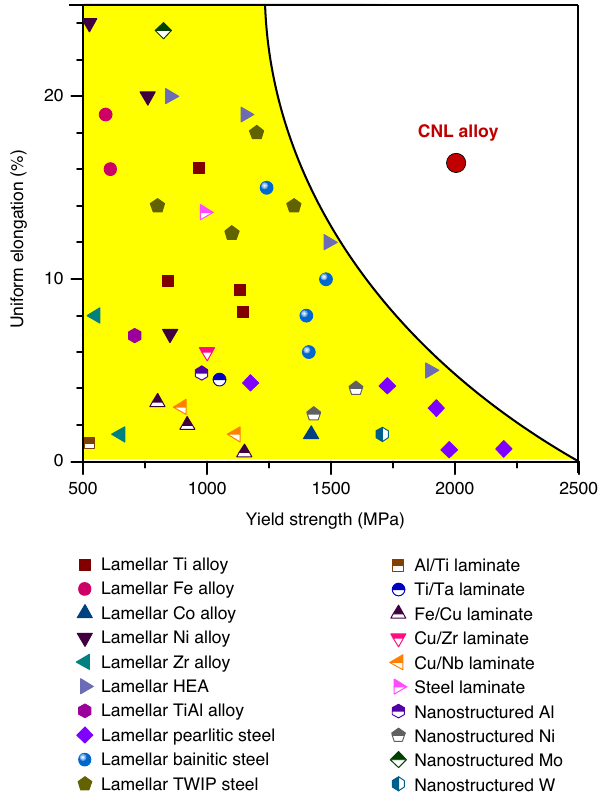
Fig. 4 Tensile properties of our CNL alloy compared with those of other materials. The reference materials include lamellar-structured alloys (Ti alloy 35,36 , Fe alloy 37 , Co alloy 38 , Ni alloy 39 , Zr alloy 40 , HEA 41,42 , TiAl alloy 43 , pearlitic steel 44,45 , bainitic steel 46 , and twinning-induced plasticity (TWIP) steel 47 ), laminated metal composites (Al/Ti 48 , Ti/Ta 49 , Fe/Cu 50 , Cu/Zr 51 , Cu/Nb 52 , and steel/steel 53 ), and nanostructured metals (Al 54 , Ni 55 , Mo 56 , and W 57 ). Our CNL alloy (red dot) clearly outperforms other high-performance materials and overcomes the long-standing dilemma of the strength-ductility